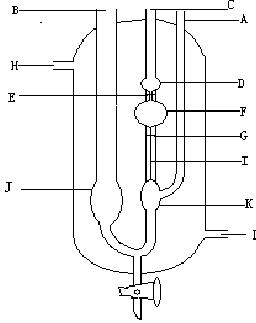
Figure 1. Ubbelohde viscometer structure: (A) air tube, (B) injection tube, (C) pipette, (D) buffering sphere, (E) upper tick mark, (F) quantify sphere, (G) lower tick mark, (I) capillary, (L) water inlet, (H) water outlet tube, (J) tube reservoir and (K) hanging horizontal reservoir.